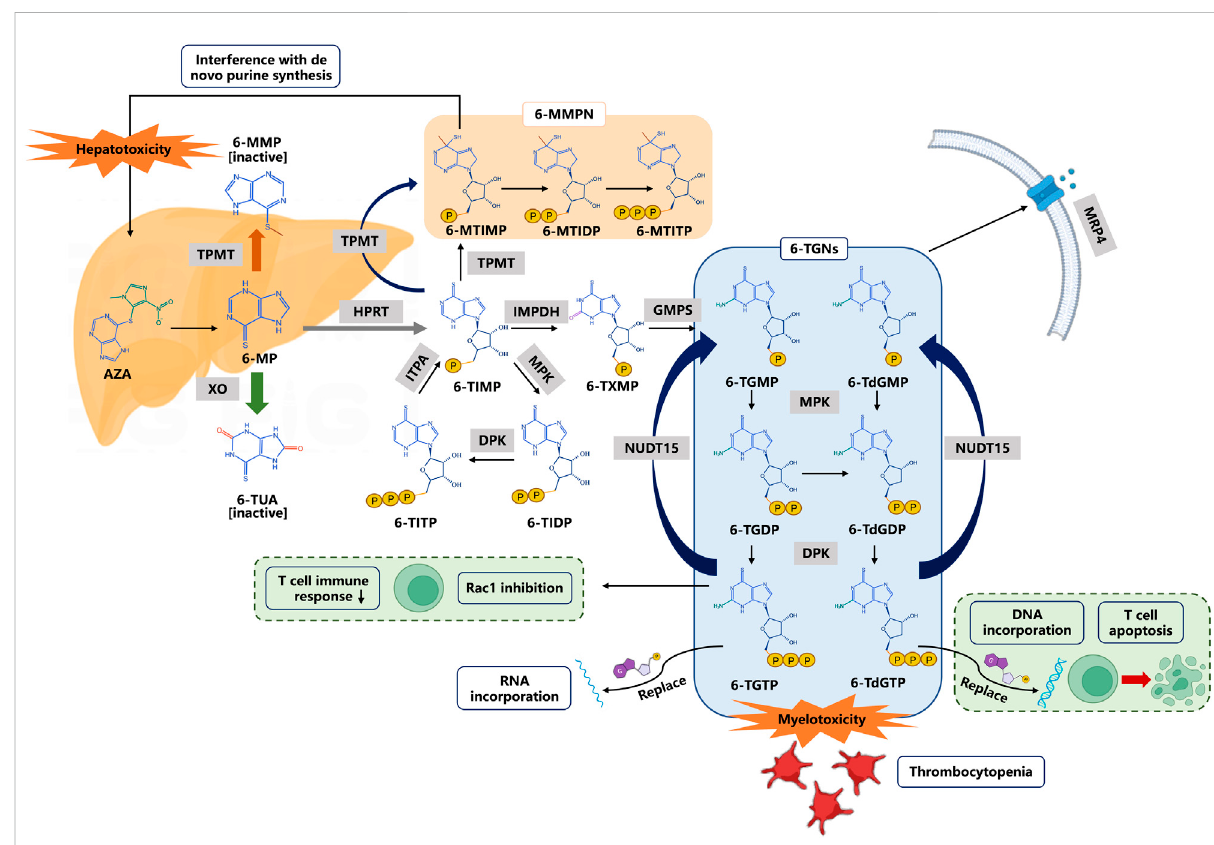
FIGURE 1 Thiopurine metabolism and transportation. 6-Thioguanine nucleotides (6-TGNs) are pharmacologic active products. 6-TGMP 6-thioguanine monophosphate, 6-TGDP 6-thioguanine diphosphate, 6-TGTP 6-thioguanine triphosphate, 6-TdGMP 6-thio-deoxyguanine monophosphate, 6- TdGDP6-thio-deoxyguaninediphosphate,6-TdGTP6-thio-deoxyguaninetriphosphate.Abbreviations:AZAazathioprine,6-MP6-mercaptopurine, 6-MMP 6-methylmercaptopurine, 6-TUA 6-thiouric acid, 6-TIMP 6-thioinosine monophosphate, 6-MMPN 6-methylmercaptopurine nucleotides, 6-MTIMP 6-methylthioinosine 5 ′ -monophosphate, 6-MTIDP 6-methylthioinosine 5 ’ -diphosphate, 6-MTITP 6-methylthioinosine 5 ′